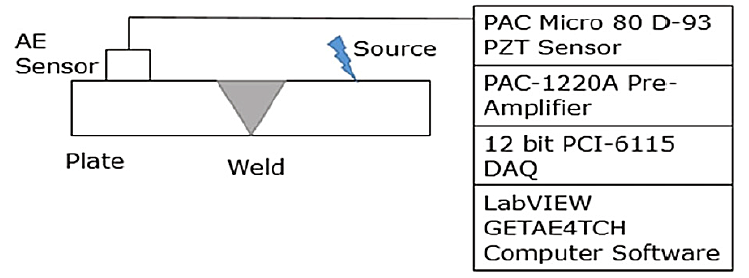
Figure 18. The arrangement of the AE sensor and acoustic source. Reprinted from Journal of Constructional Steel Research, Volume 134, Droubi, M.G.; Faisal, N.H.; Orr, F.; Steel, J.A.; El-Shaib, M. Acoustic Emission Method for Defect Detection and Identification in Carbon Steel Welded Joints, Page 28–37, Year 2017 with permission from Elsevier